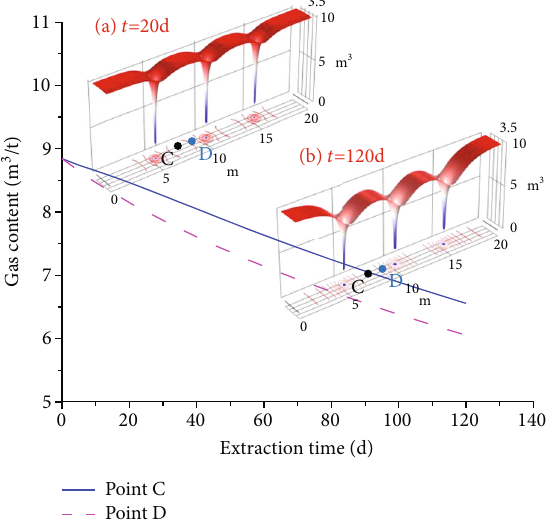
Figure 13: Variation of gas content with time when borehole diameter is 94mm.